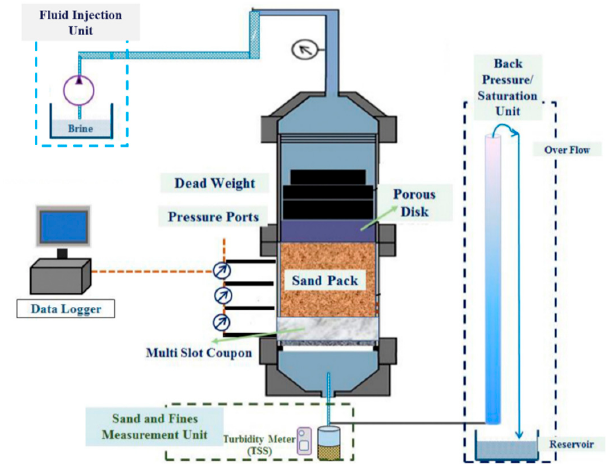
Figure 4. Schematic view the sand retention test (SRT) facility.